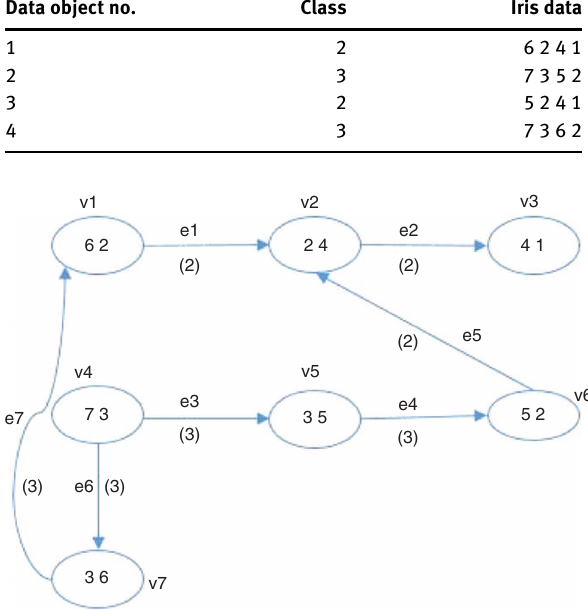
Figure 3: Feature Pair Index Graph. Table 2: Edge Table of Sample